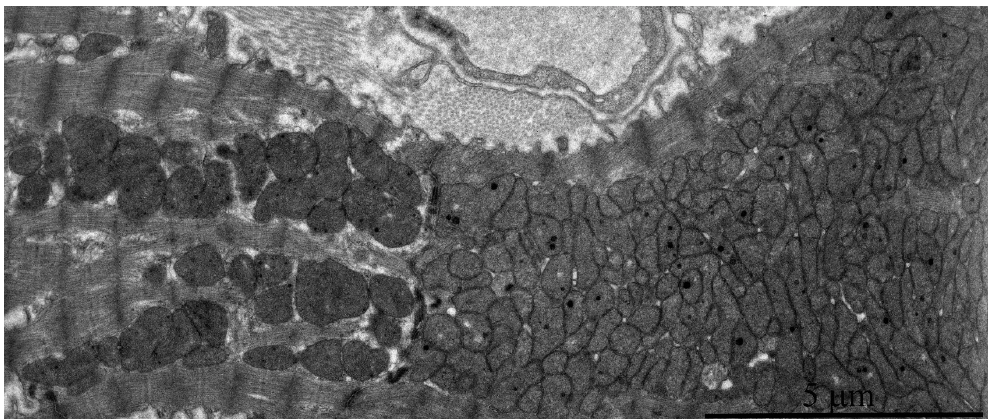
Figure 8. Ultrastructure of individual cardiomyocyte mitochondria in a 11-year-old naked mole rat: ( a) Mitochondria with disrupted crista ultrastructure. The arrow shows the appearance of a bundle of cristae. ( b ) The bundle at higher magnification. ( c ) Mitochondrial population of a left ventricular cardiomyocyte. Mitochondria with bundles are very rare.